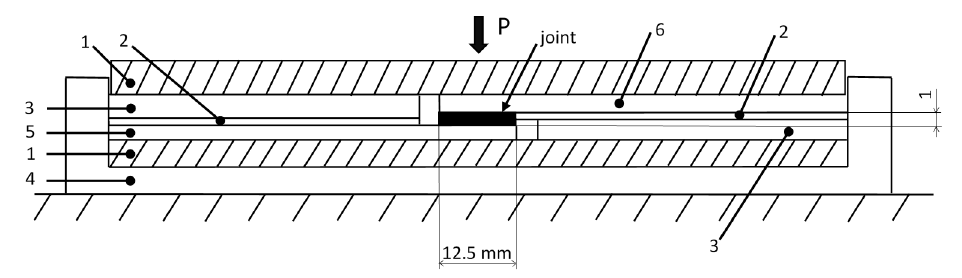
Figure 9. Scheme of a stand for adhesion of a single-lap specimen: 1, 3—steel divider, 2—PTFE divider, 4—base of the stand, 5,6—elements of the specimen, P—clamp force.